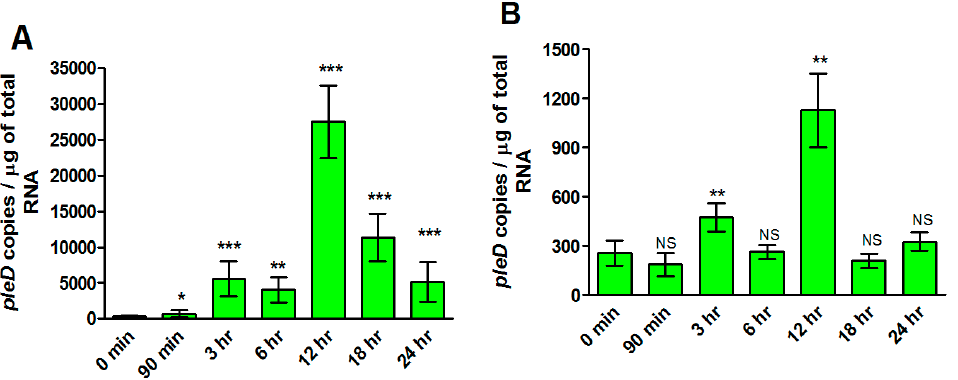
Figure 5. Absolute quantification of pleD expression in R. rickettsii str. Sheila Smith and Iowa during the infection of host endothelial cells, in vitro. Significant differences in pleD expression levels are observed in host cells infected with R. rickettsii str. Sheila Smith ( A ) versus R. rickettsii str. Iowa ( B ) strain. Highest expression of pleD is observed in both R. rickettsii str. Sheila Smith and R. rickettsii str. Iowa at 12 h post-infection when compared to the control (0 min). * p ≤ 0.05, ** p ≤ 0.01, *** p ≤ 0.001, not significant (NS) p > 0.05.